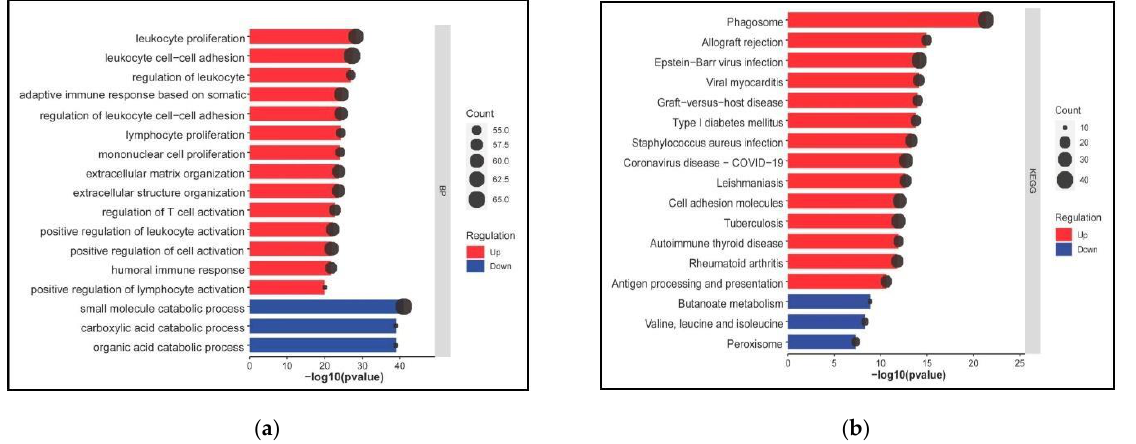
Figure 4. Functional enrichment analysis of DEGs. ( a ) Gene Ontology biological processes and ( b ) KEGG pathways. Bars for upregulated are colored in red while downregulated are depicted in blue. Among those, phagosome (count = 40, p = 4.57 × 10 −22 ), allograft rejection (count = 18, p = 1.10 × 10 −15 ), Epstein-Barr virus infection (count = 37, p = 6.80 × 10 −15 ), viral myocarditis (count = 21, p = 7.51 × 10 −15 ), graft-versus-host disease (count = 18, p = 1 × 10 −14 ), type I diabetes mellitus (count = 18, p = 1.66 × 10 −14 ), Staphylococcus aureus infection (count = 25, p = 4.67 × 10 −14 ), Coronavirus disease-COVID-19 (count = 30, p = 1.82 × 10 −13 ), Leishmaniasis (count = 22, p = 2.03 × 10 −13 ), cell adhesion biomolecules (count = 30, p = 9 × 10 −13 ), tuberculosis (count = 32, p = 1.20 × 10 −12 ), autoimmune thyroid disease (count = 18, p = 1.21 × 10 −12 ), rheumatoid arthritis (count = 23, p = 1.63 × 10 −12 ) and antigen processing and presentation (count = 20, p = 2.36 × 10 −11 ) are induced pathways (Table S3). In contrast, small molecule catabolic process (count = 65, p = 9.17 × 10 −12 ), organic acid catabolic process (count = 53, p = 1.07 × 10 −39 ) and carboxylic acid catabolic process (count = 53, p = 1.07 × 10 −39 ) are repressed biological processes. Likely (Figure 3B, Table S2) route blades, butanoate metabolism (count = 10, p = 1.32 × 10 −9 ), valine, leucine and isoleucine degradation (count = 12, p = 4.83 × 10 −9 ) and peroxisome related pathways (count = 14, p = 4.81 × 10 −8 ) (Figure 4b, Table S3). Interestingly, upregulated DEGs were implicated in autoimmune disorders and bacterial and viral infections such as COVID-19, whereas downregulated DEGs were involved with amino acid metabolism pathways. Altogether, the most enriched pathways demonstrate the significant role of the DEGs in diabetic nephropathy, activating immunological and defense responses commonly affected in the SARS-CoV-2 scenario. Opposite, the top enriched biological processes are linked to amino acid and metabolism pathways, suggesting their role in the consequence is a profound disturbance in glycolysis and lipid and amino acid metabolism. 3.3. Transcriptional Reprogramming of Gene Upregulation Is a Common Mechanism for DKD and COVID-19 Conditions Notably, our results showed that ~67.6% of DEGs in DKD samples are upregulated. From the 632 upregulated genes, 41 out of the 560 genes are involved in COVID-19 pathways (Figure 5a, Table S4). Interestingly, the overlapped DEGs among DKD and COVID-19 are affecting pathways that include immune, diabetes and other comorbidities according to their role in KEGG, Reactome and GO terms (Figure 5b).